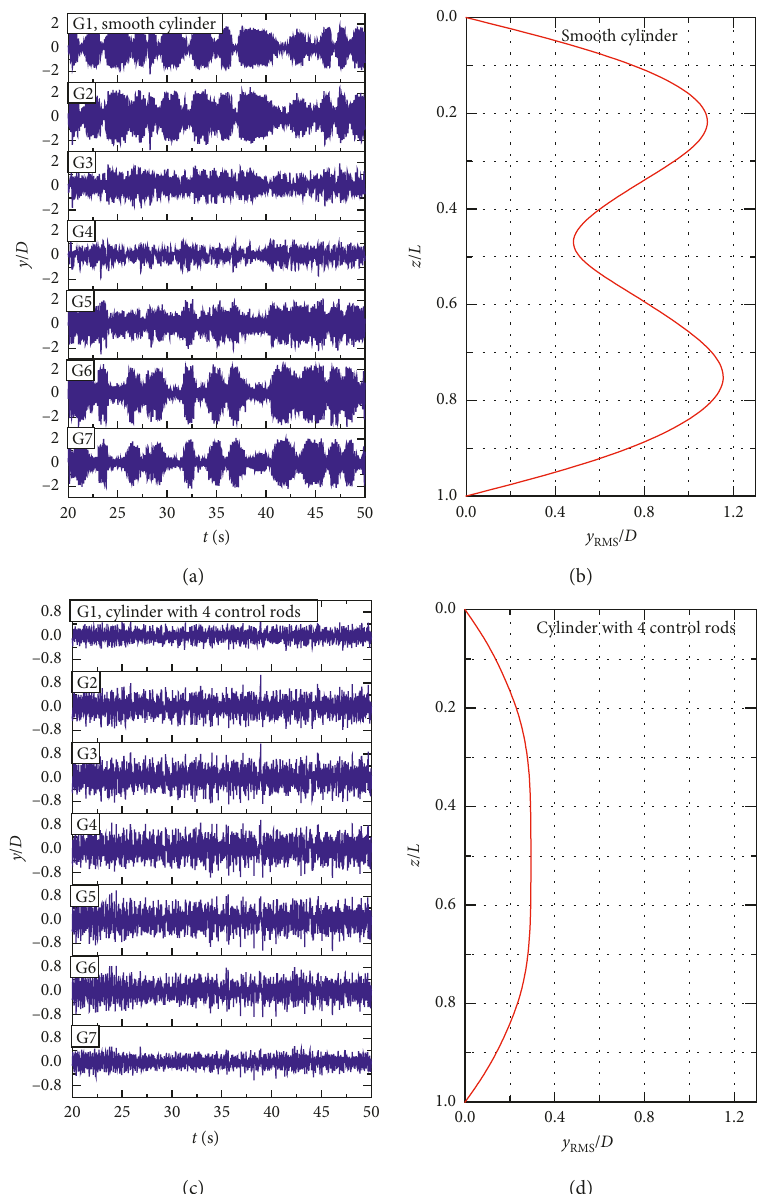
Figure 10: Displacement response characteristic of the inclined flexible cylinder ( α shedding at U 0.85m/s (the first column presents the time history of the nondimensional displacement ((a), (c)), the second column (cid:31) presents the spanwise evolutions of the RMS displacements ((b),